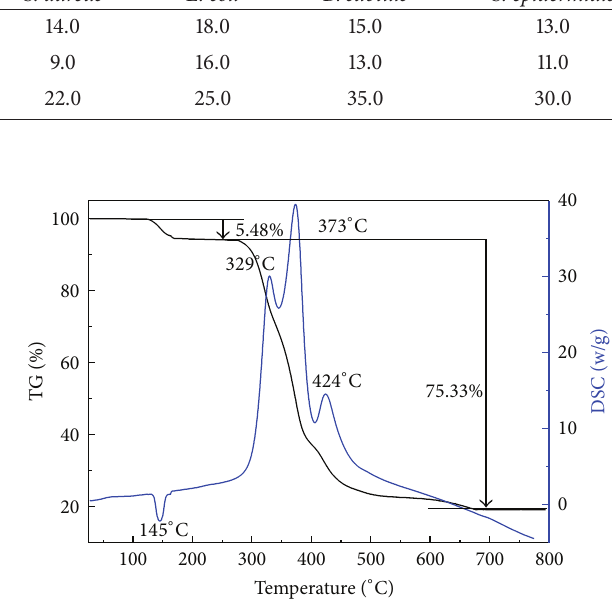
Figure 2: TG and DSC curves of the title